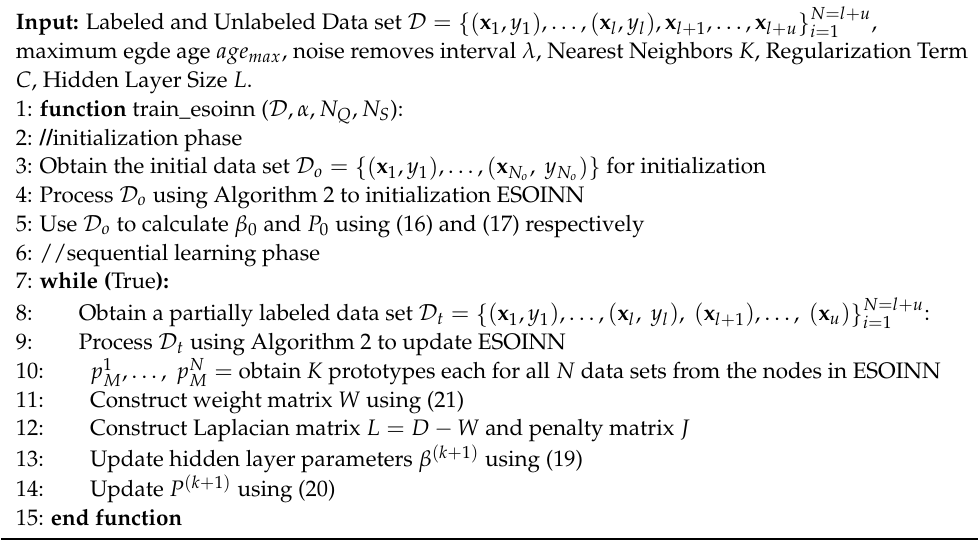
Algorithm 3. Prototype Regularized Semi-Supervised Online Extreme Learning